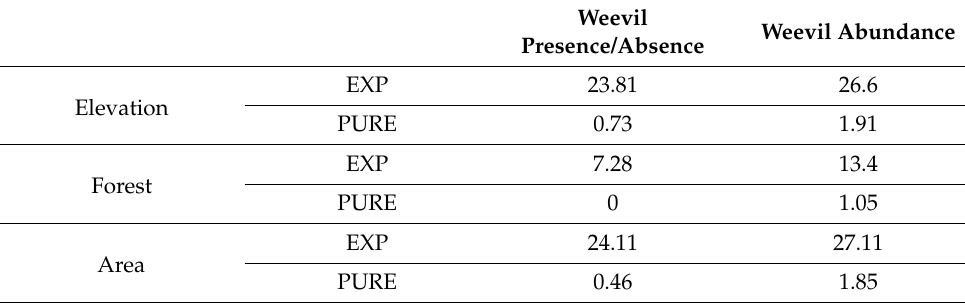
Table 4. Percentage of variability explained by the environmental